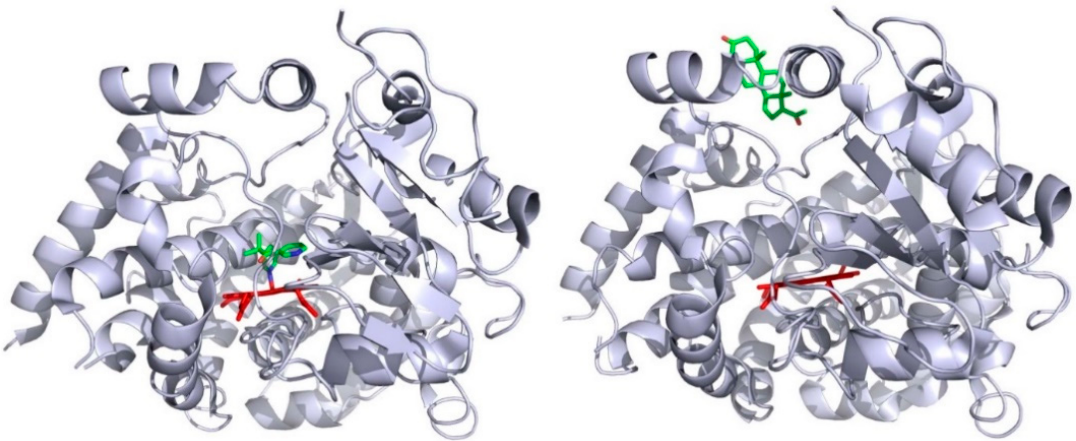
Figure 2. Positions of metyrapone ( left panel ) and progesterone ( right panel ) bound to CYP3A4. The crystal structures are taken from the Protein Data Bank entry 1w0f ( left panel ) and 1w0g ( right panel ) [50]. The heme is shown in red and the ligands are colored by atom type (green, carbon; red, oxygen, blue, nitrogen).